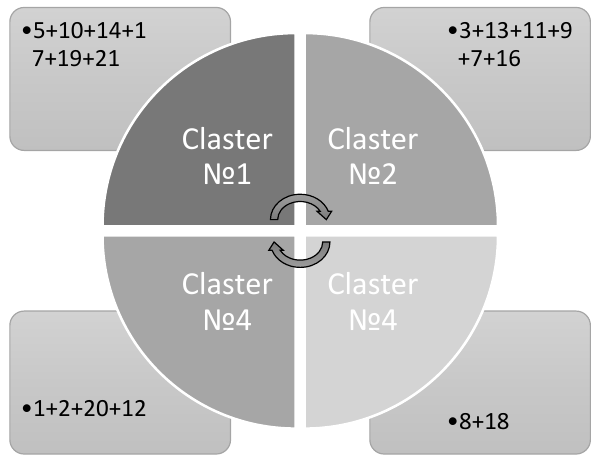
Figure 4. The result of the district clusterization in Cherkasy